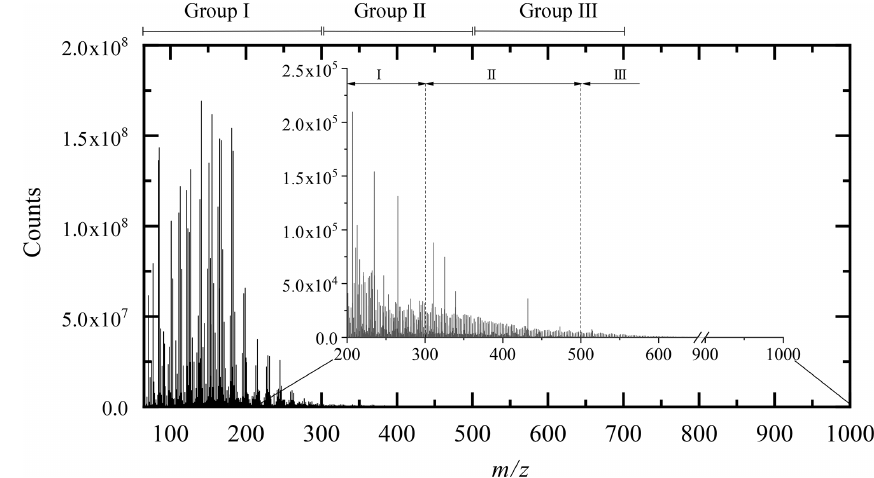
Figure 1. Limonene oxidation sample analyzed by FIA and HESI (negative mode, sheath gas flow of 12a.u., auxiliary gas flow of 6a.u., sweep gas flow of 0a.u., voltage 3.8kV, capillary temperature 300 ◦ C, vaporizer temperature 120 ◦ C, Hamilton syringe at a flow rate of 3µLmin − 1 ).